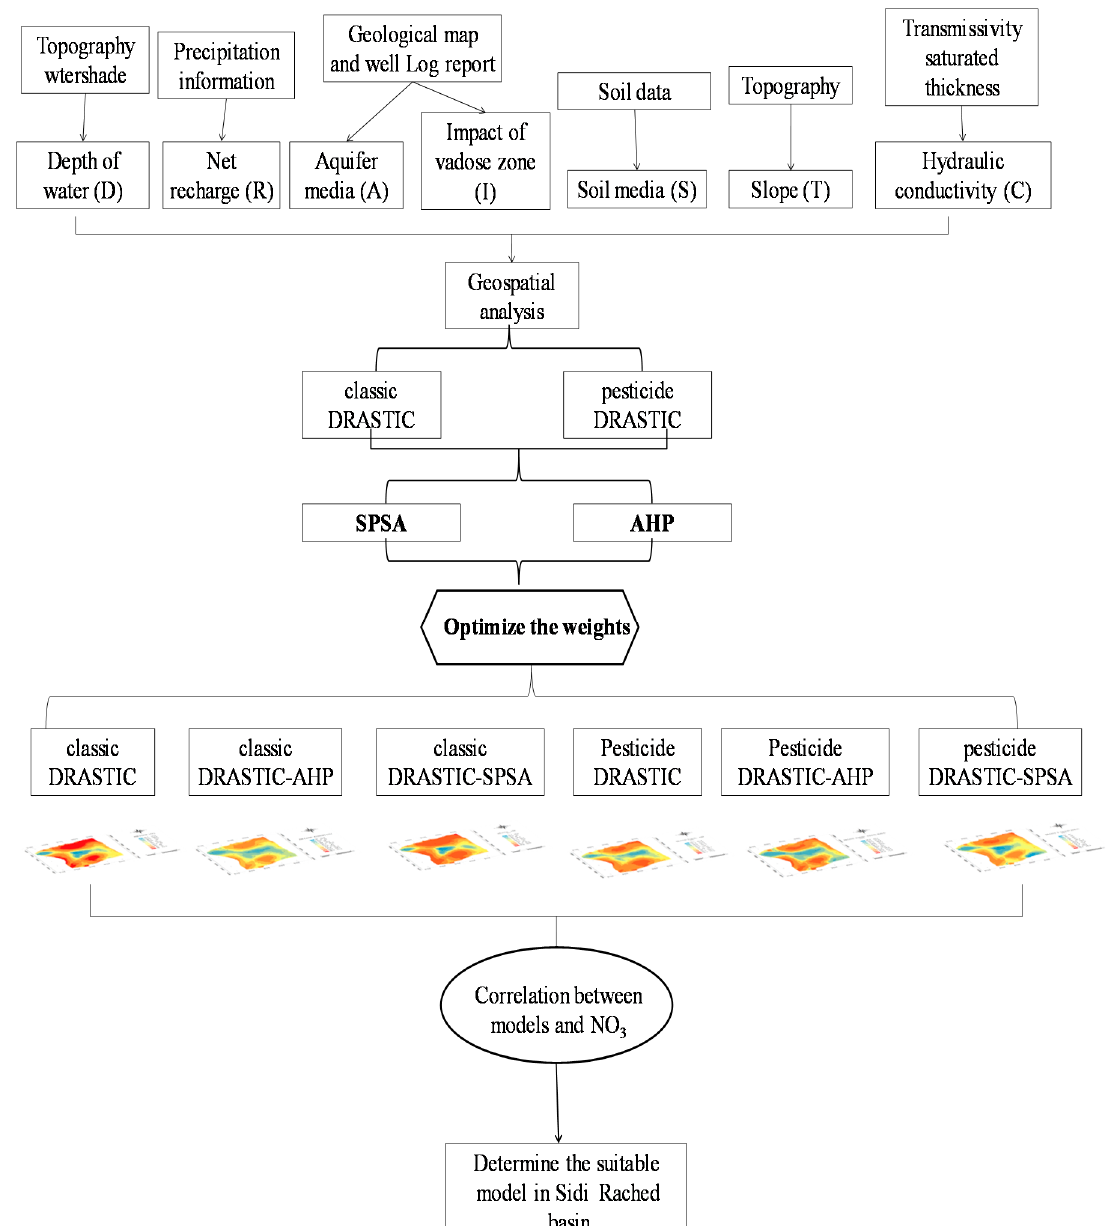
Figure 5. The flowchart of the methodology. SPSA: Single-Parameter Sensitivity Analysis, AHP: Analytic Hierarchy Process.